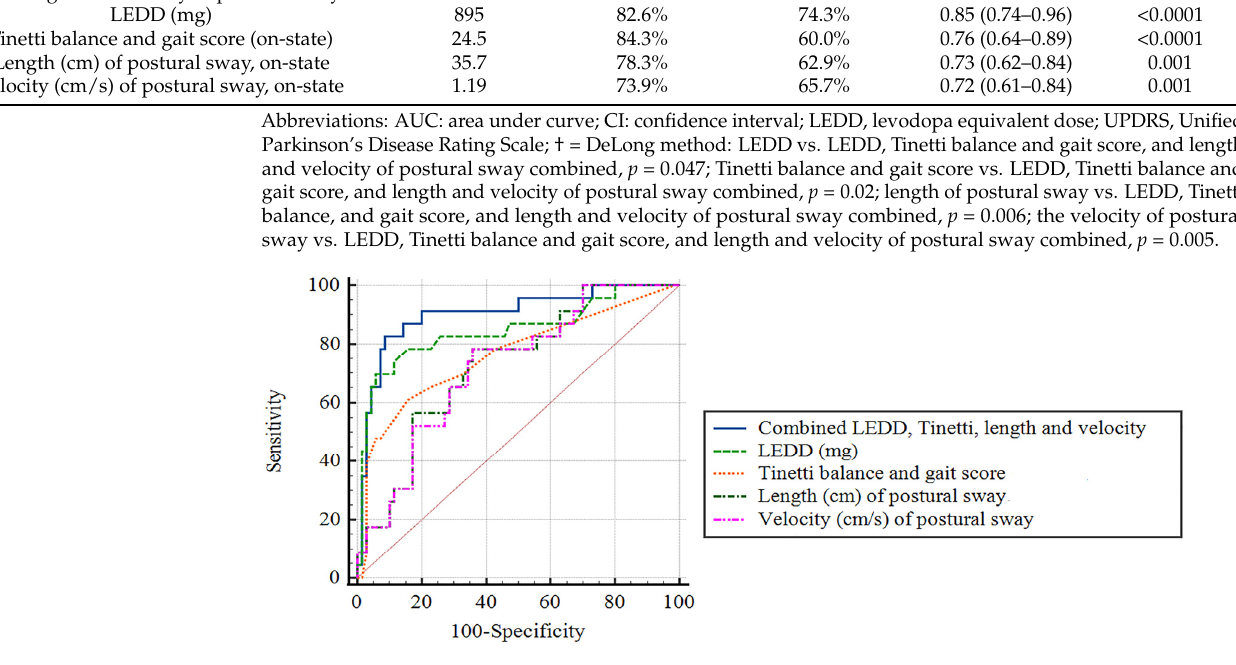
Figure 4. Receiver-operator characteristic curves for predicting the presence of prospective falls. The diagnostic accuracy of the LEDD, UPDRS total score (on-state), and length and velocity in standing postural sway (on-state), and its combinations, is shown based on the receiver operating characteristic curve analysis.